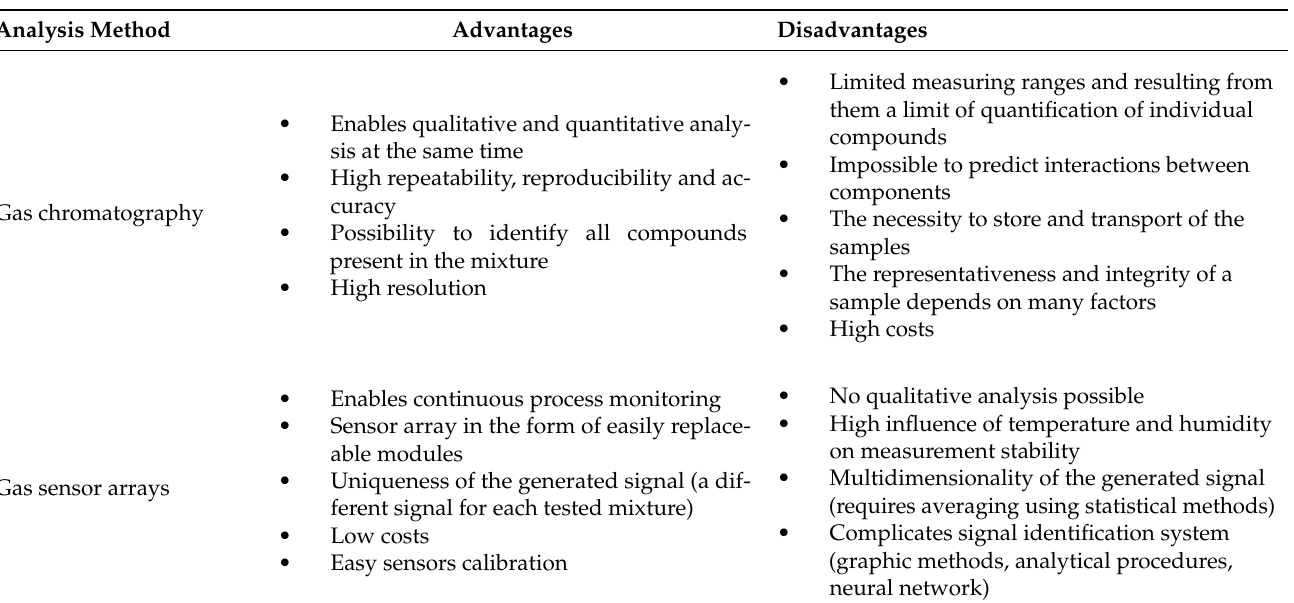
Table 2. Advantages and disadvantages of gas chromatography and sensor arrays. Analysis